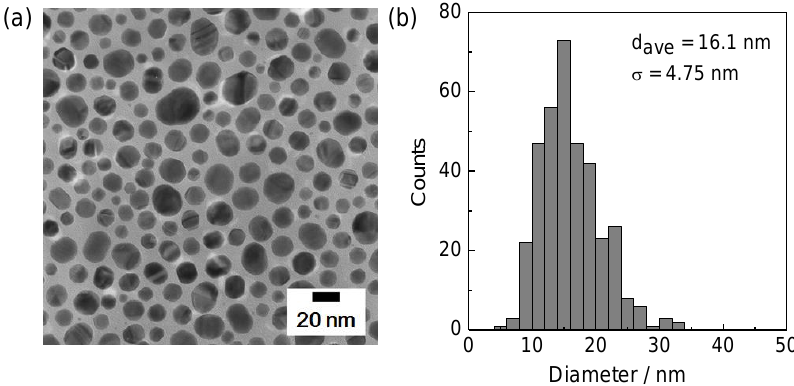
Figure 3. ( a ) TEM image and ( b ) the particle size histogram of